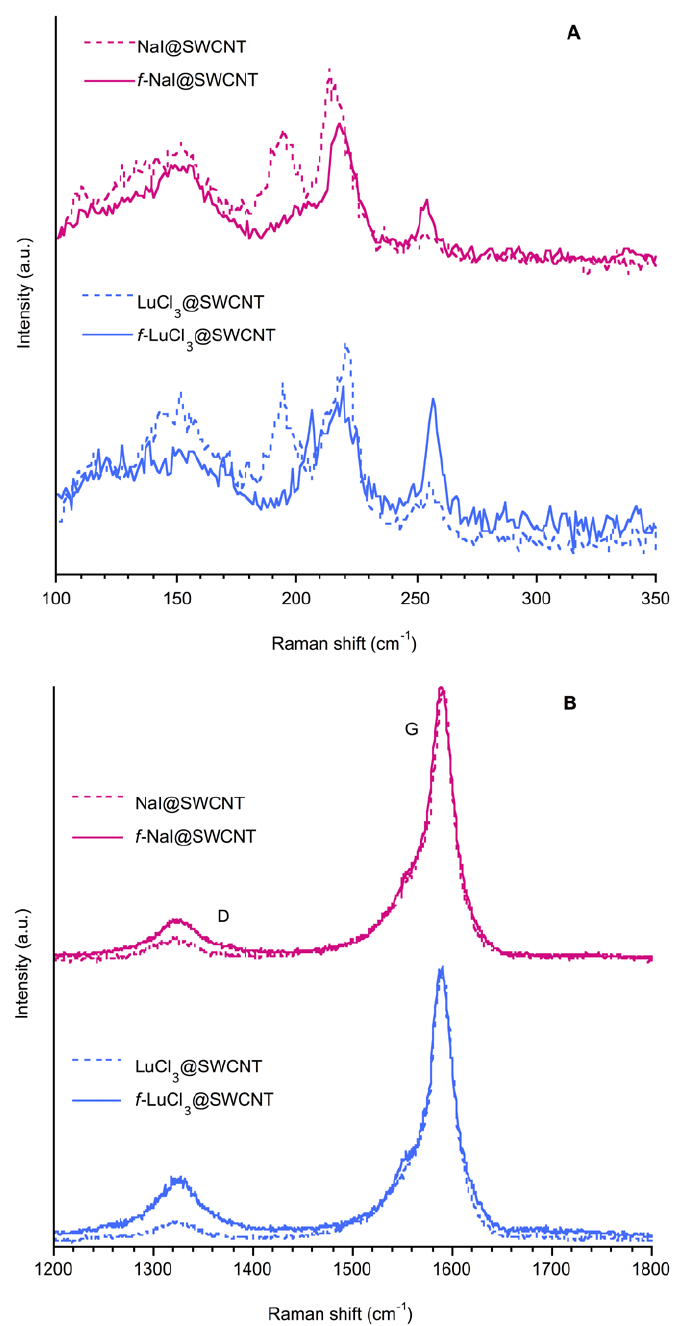
Figure 5. Raman spectra of 2 (dashed lines) and 4 (solid lines) with a 633 nm laser. Panel A : RBMs Figure 5 mode; Panel B : D mode and G mode. Spectra are normalized for ease of